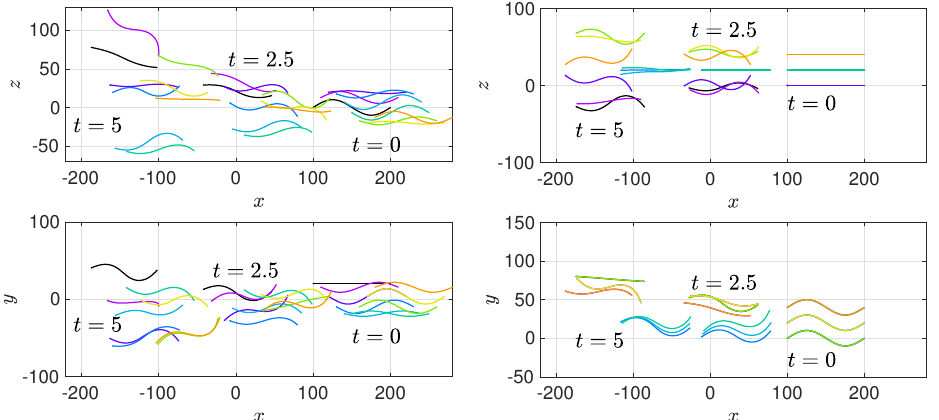
Figure 7. Snapshots of locations of flagella over time in 2D, overlaid. Times shown are every 2.5 s (as labeled), equivalent to 25 beats. Head positions started near x = 100 µ m (see Figure 4) and flagella move in the negative x -direction. All units are in µ m. Colors correspond to the flagellum of the same color from the initial configurations in Figure